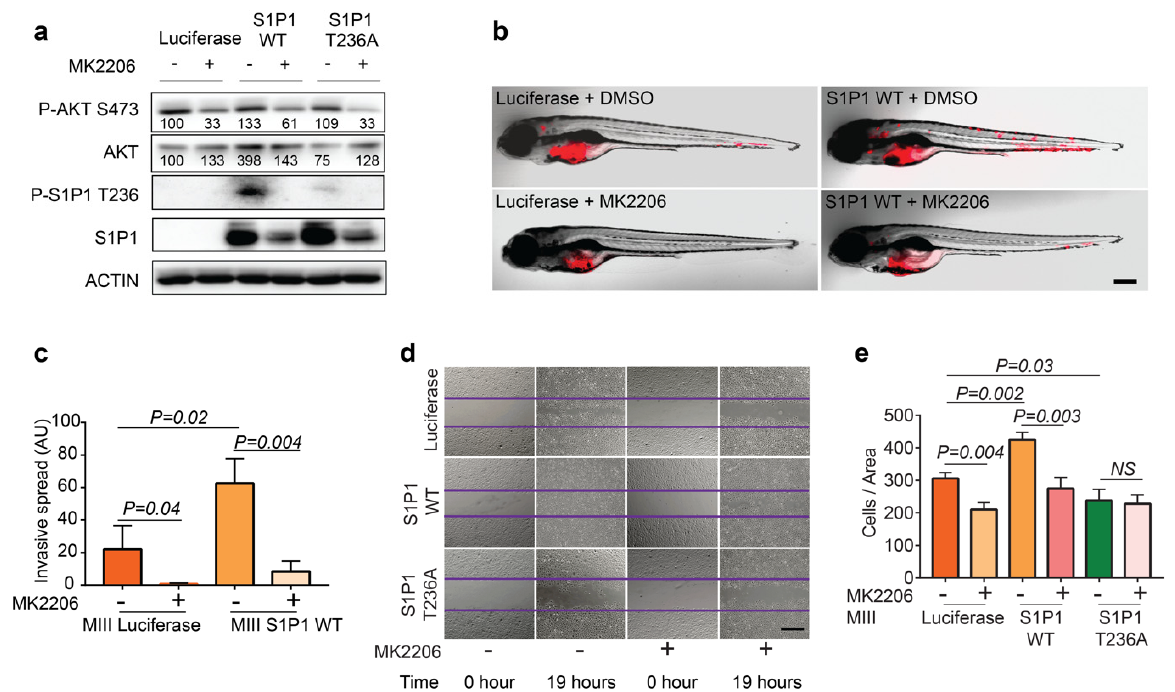
Figure 5. AKT-mediated phosphorylation of S1P1 T236 drives TNBC invasion. ( a ) Western blot anal- ysis of P-AKT S473, AKT, P-S1P1 T236, and S1P1 expression in MIII cells overexpressing Luciferase ,